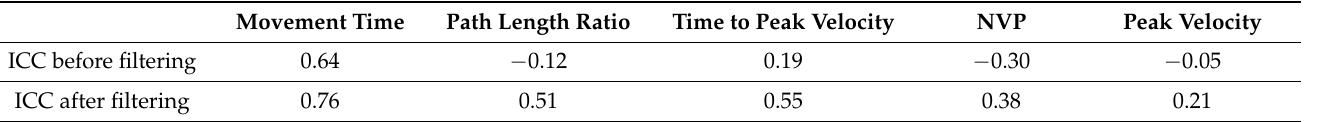
Table 2. Reliability improvements through filtering. The filtering consisted of applying a 2nd